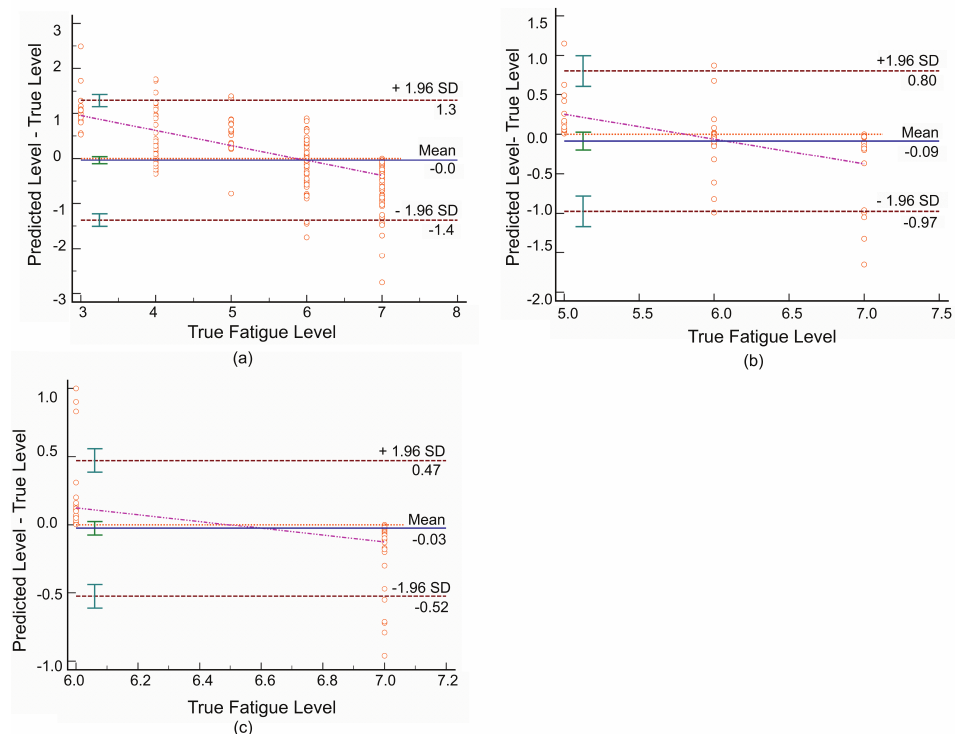
Figure 8. Example Bland–Altman (B&A) plot of a participant (subject =5) with FP data for (a) squat, (b) high knee jack, and (c) corkscrew toe-touch. The blue line represents the mean differences. The red lines represent the 95% CI of the limits of agreement (the 1.96 SD). The pink line is the regression line of the differences. The orange dotted line is the line of equality (difference =0).